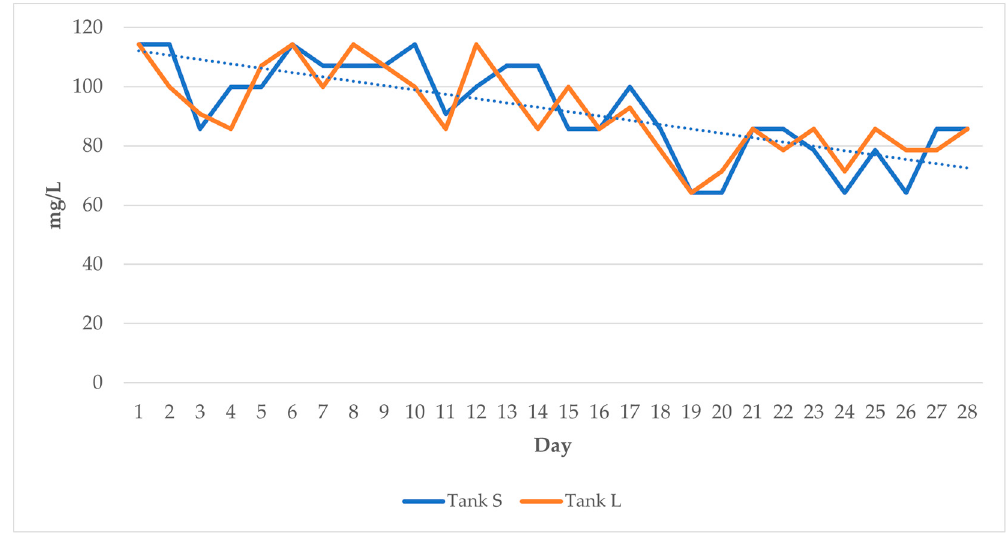
Figure 7. Nitrate nitrogen levels in mg/l for both tanks over the 28-day experiment.